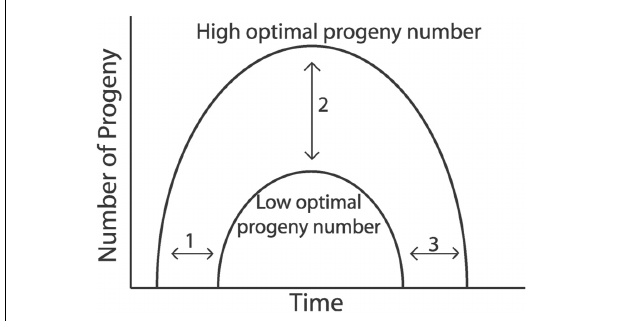
FIGURE 9 | Optimal progeny number theory. The schematic of hypothetical progeny production curves display how progeny number can be controlled: (1) timing of onset of reproduction, (2) quantity of progeny, and (3) timing of cessation of reproduction or reproductive aging. Thus, reproductive aging is one of the critical inputs that controls progeny number. According to the theory, there is an optimal progeny number that stabilizes population dynamics and support long-term survival of populations. Therefore, reproductive aging can be an advantageous trait that might be sculpted by evolution. Adapted from Hughes et al.